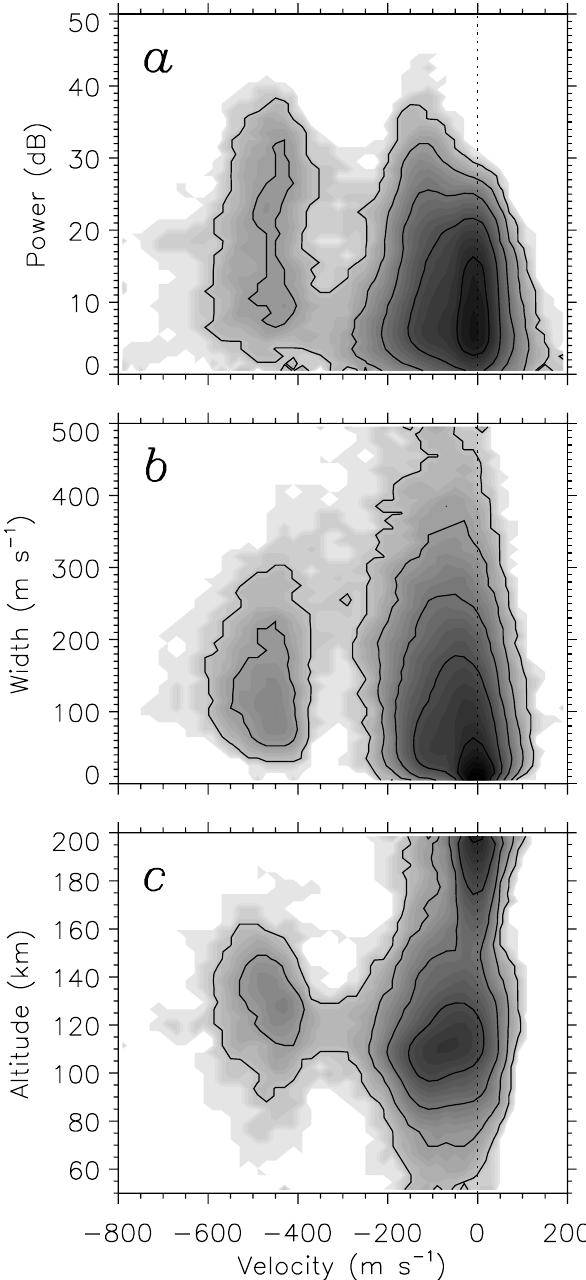
Fig. 7. The density of echoes in (a) power-velocity, (b) width- velocity, and (c) altitude-velocity space for the interval 02:00 to 04:10UT on 23 September 2000. The shading indicates density on a logarithmic